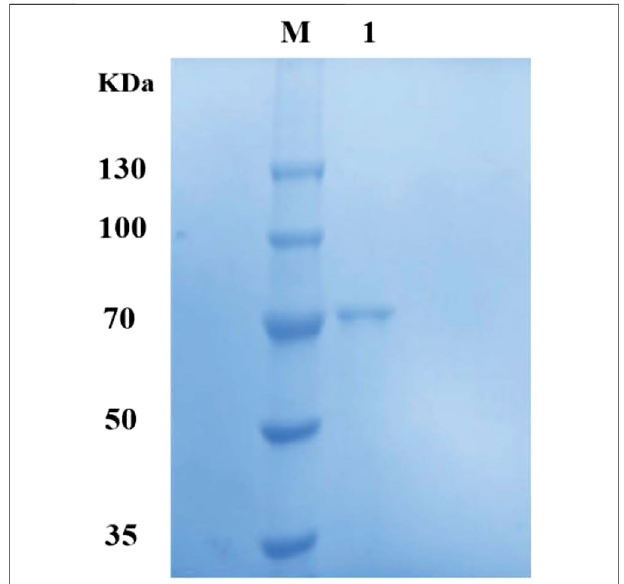
FIGURE 3 | Sodium dodecyl sulfate-polyacrylamide gel electrophoresis (SDS-PAGE) of dextranase from G6-4B. M, protein marker; Lane 1, puri fi ed